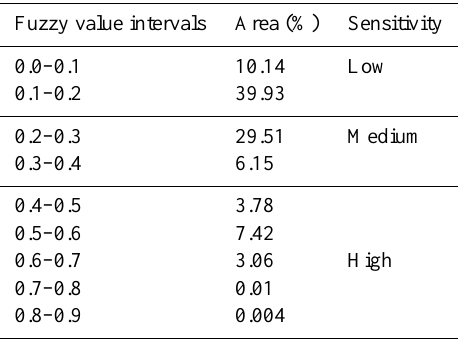
Figure 12. Sensitivity of the areas to wind erosion based on the vegetation cover. Table 3. Spatial distribution of the sensitivity to wind erosion (cal- culated by soil, vegetation and wind speed data).